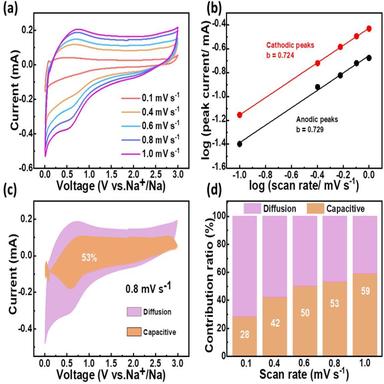
(a) CV curves of NBPC-800 at different scan rates. (b) Relationship between log(i) and log(v) for NBPC-800. (c) CV curves with capacitive- and diffusioncontrolled contributions at 0.8 mV s − 1 and (d) Bar chart showing the contribution ratio of capacitive- and diffusion-controlled capacities at different scan rates.